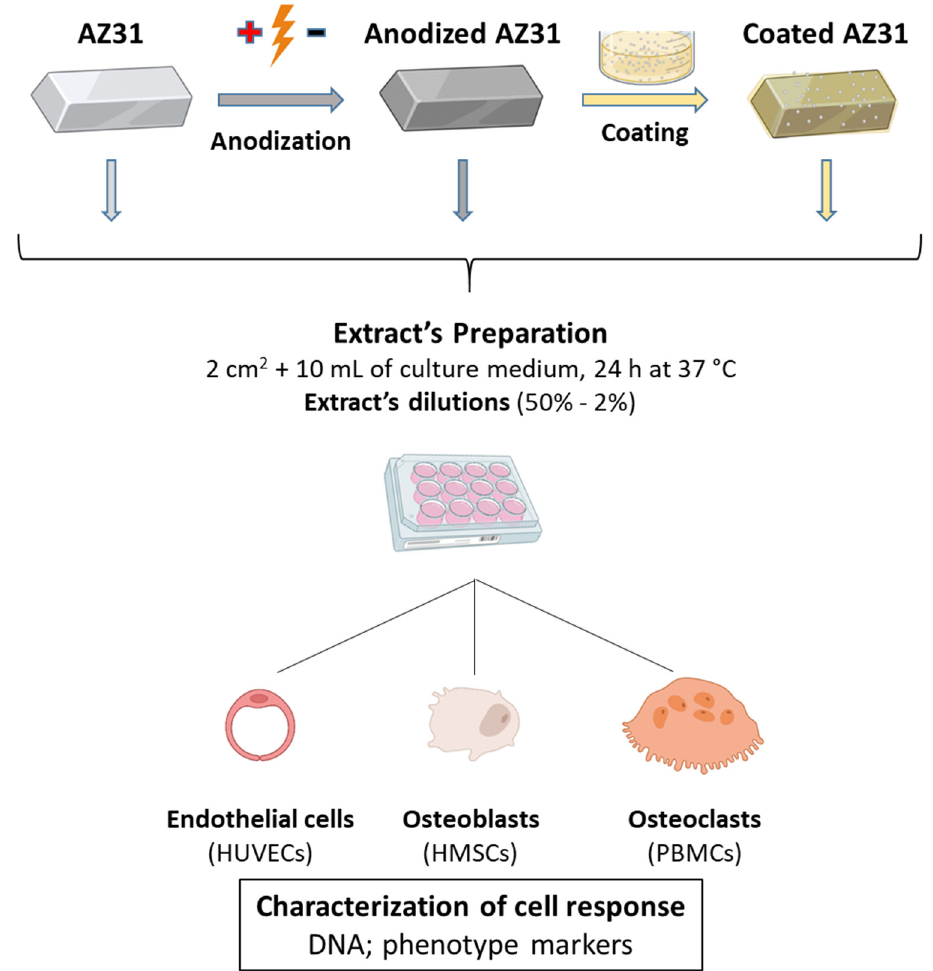
Figure 1. Diagram of the experimental protocol used to evaluate the effects of the extracts from the Mg–based substrates on relevant cells involved in bone regeneration. Mg-based substrates on relevant cells involved in bone